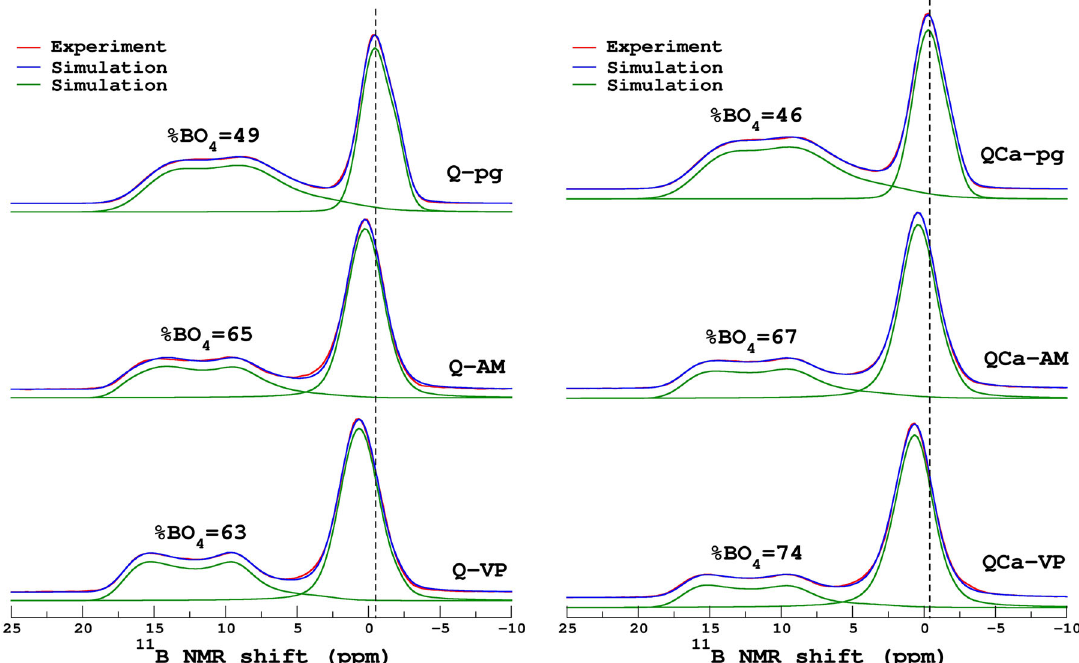
Fig. 7 11 B MAS NMR spectra. Experimental and simulated 11 B MAS NMR spectra of pg, AM and VP samples; (left column) Q glass and (right column) QCa glass. The spectra have been simulated as described in refs. 15,65 . Four (pg) components have been fi tted using the pristine glass (2 × BO 3 and 2 × BO 4 ). While keeping the pg NMR parameters constant, two components have been fi tted for the altered glasses (1 × BO 3 and 1 × BO 4 ). For altered glasses, the residual glass contribution was found to be around 10